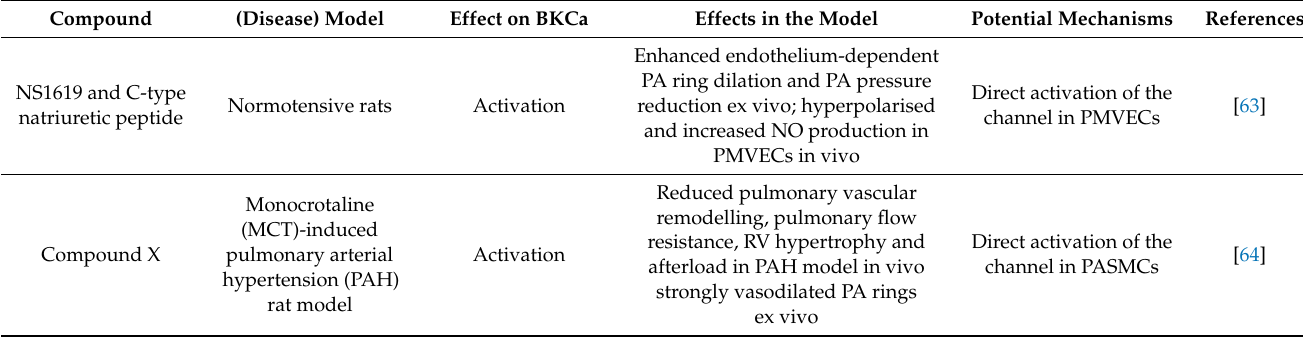
Table 1. Effect of pharmacological interventions of BKCa α -subunit in various disease models.